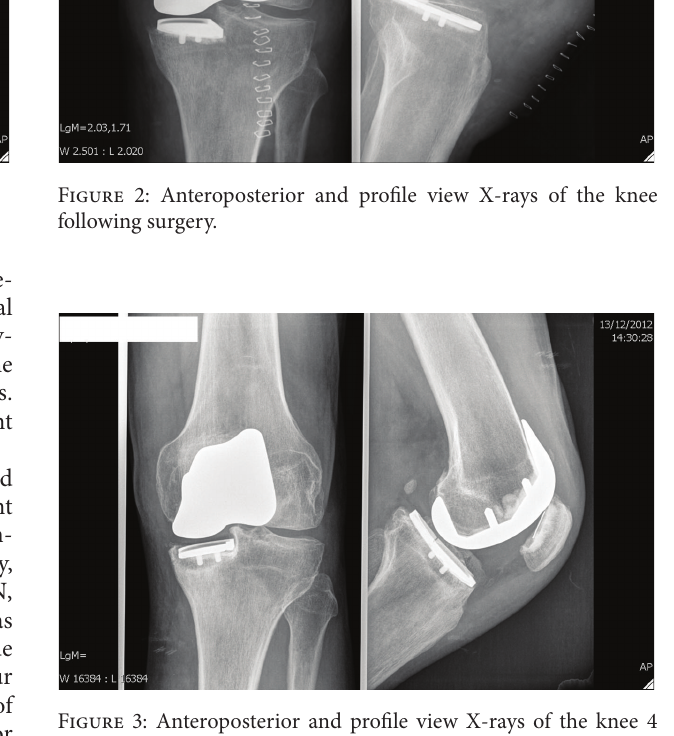
Figure 3: Anteroposterior and profile view X-rays of the knee 4 years after surgery. Arrow indicates fracture of the